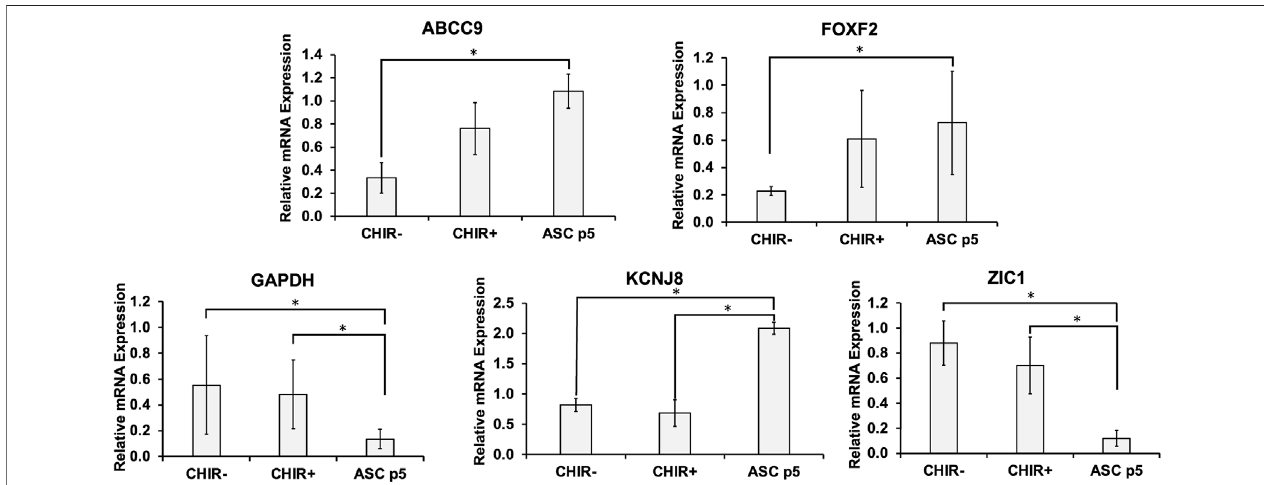
FIGURE2| mRNAlevelsforbrain-speci fi cmarkersinthederivedpericytes(iPCs).mRNAexpressionwasdeterminedbyRT-PCR.BrainpericytesderivedwithWnt activator CHIR99021 (CHIR) were compared to those derived in the absence of CHIR and human adipose-derived stem cells (ASCs). Gene markers tested include ABCC9 , FOXF2 , KCNJ8 , ZIC1 ,and GAPDH .Expressionwasnormalizedtothenon-CHIRpericytes.N=6.TheRT-PCRresultswereexpressedasthemean±standard deviation. Statistical analysis was performed by one-way ANOVA. * indicates p < 0.05 for the compared groups.